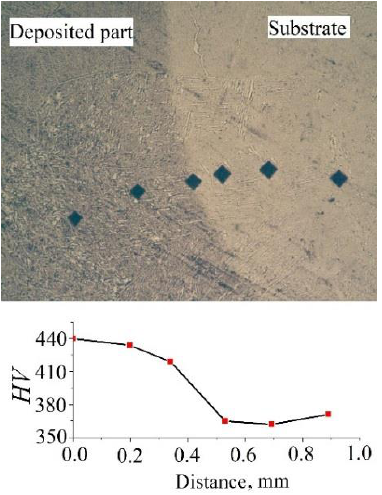
Figure 9. The distribution of hardness at the place of melting of the substrate and manufactured detail No. 5.